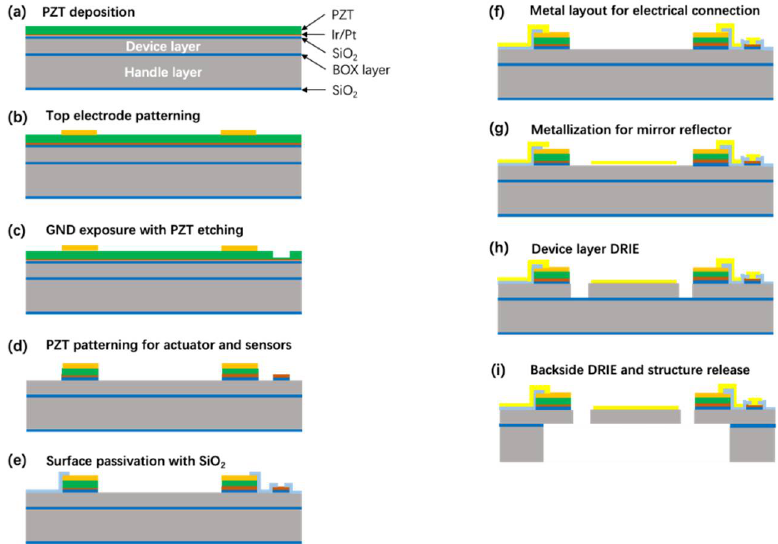
Figure 4. Microfabrication process flow of the piezoelectric 2D MEMS mirror. ( a ) PZT deposition. ( b ) Top electrode patterning. ( c ) GND exposure with PZT etching. ( d ) PZT patterning for actuator and sensors. ( e ) Surface passivation with SiO 2 . (f) Metal layout for electrical connection. ( g ) Metallization for mirror reflector. ( h ) Device layer DRIE. ( i ) Backside DRIE and structure release.